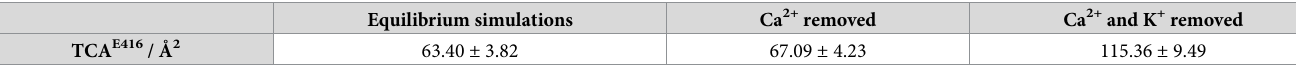
Table 2. Average TCA E416 (with associated standard deviation) from the simulations. For the equilibrium simulations, TCA is calculated from the final 100 ns over the three replicates. For systems where cations have been removed, TCA is calculated from the final 20 ns over the two replicates. Equilibrium